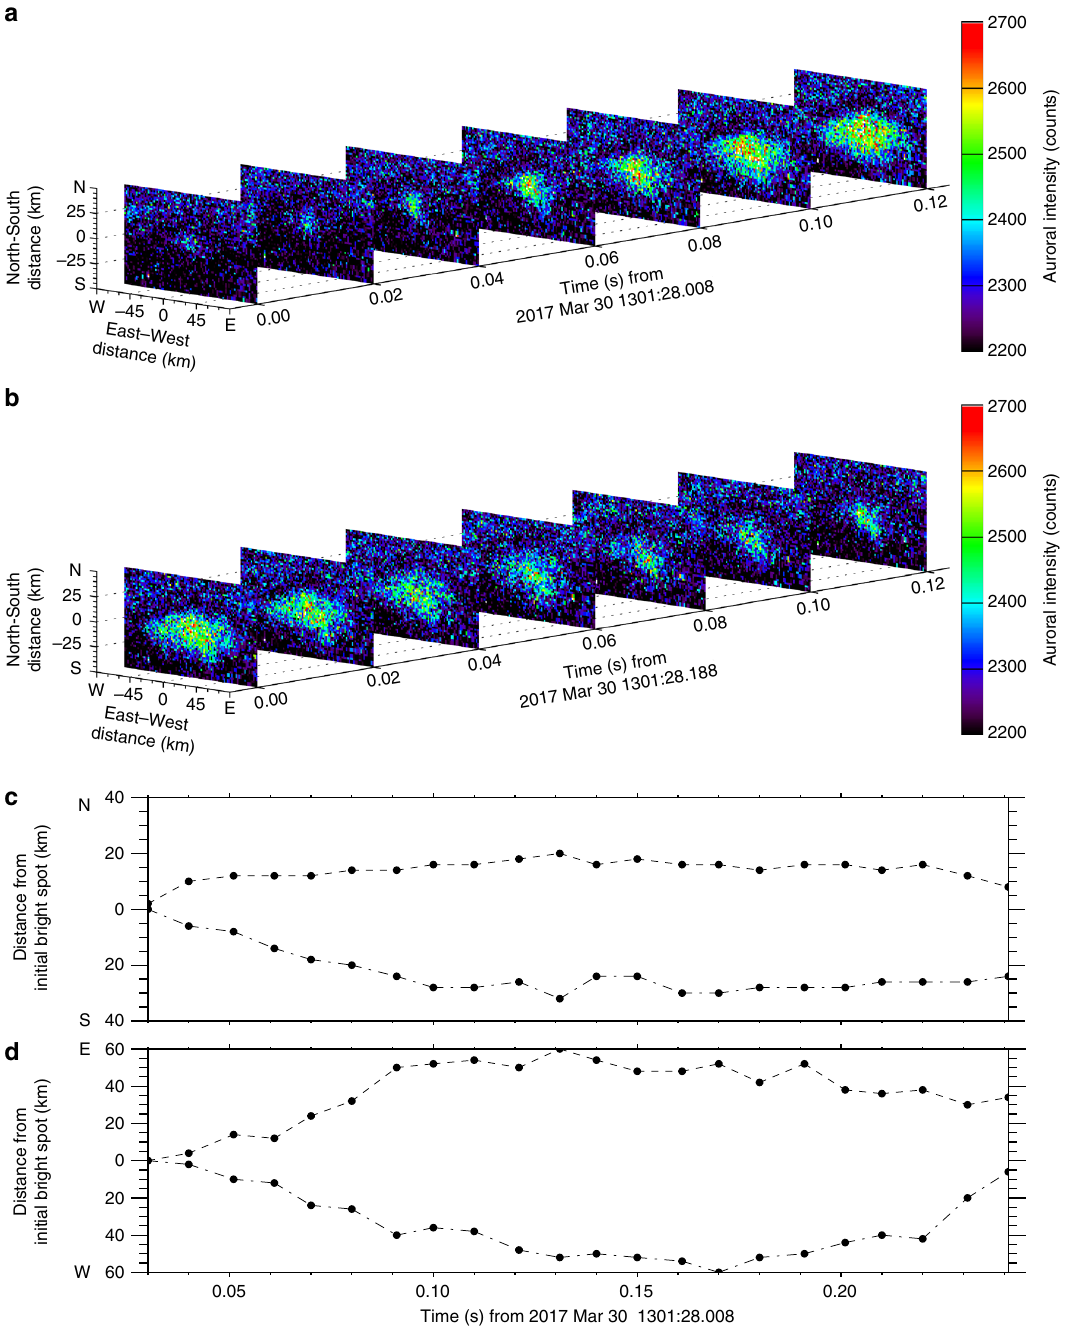
Fig. 4 Spatiotemporal evolution of the auroral fl ash in the ionosphere. a The initial spatial expansion and b the gradual contraction of the auroral fl ash. The spatial developments in c the magnetic north (dashed line) – south (dot-and-dash line) and d east (dashed line) – west (dot-and-dash line) directions from the initial bright